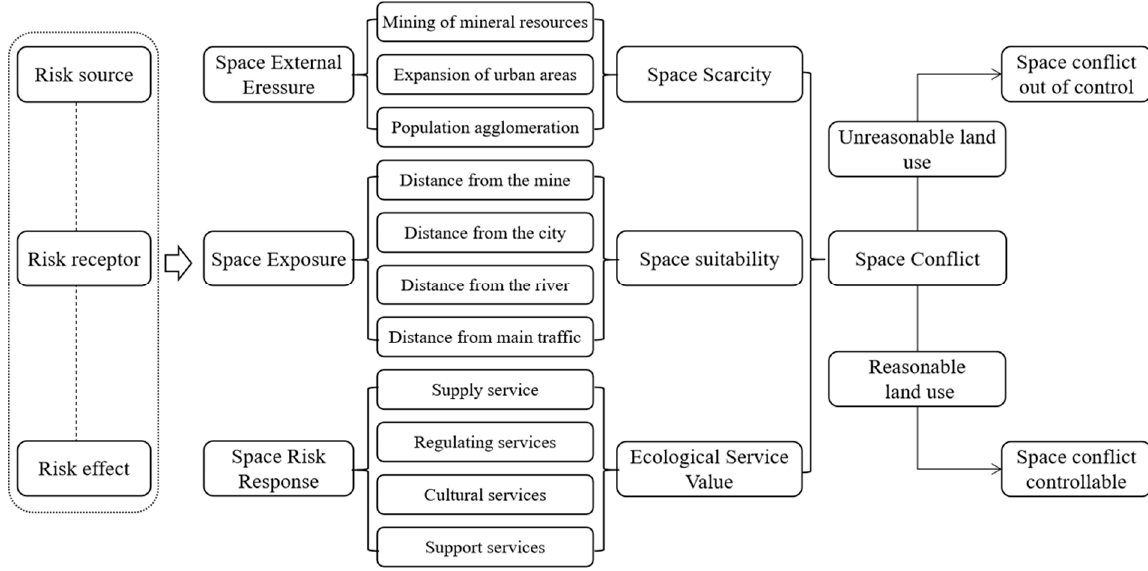
Figure 1. The framework of spatial conflict analysis.